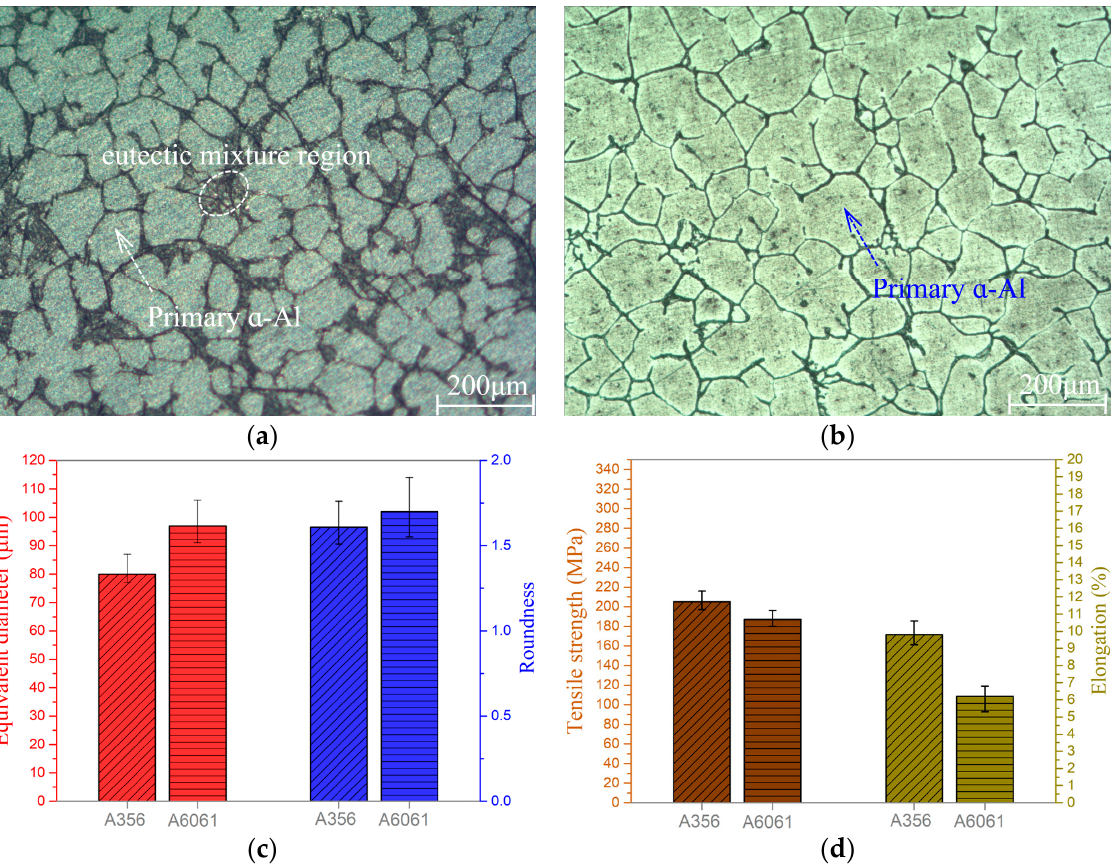
Figure 4. Semi-solid slurry made by rheo process (cooling and EMS): ( a ) A356 microstructures; ( b ) A6061 microstructures; ( c ) equivalent diameter and roundness of primary α -Al grains; ( d ) tensile strength and elongation.